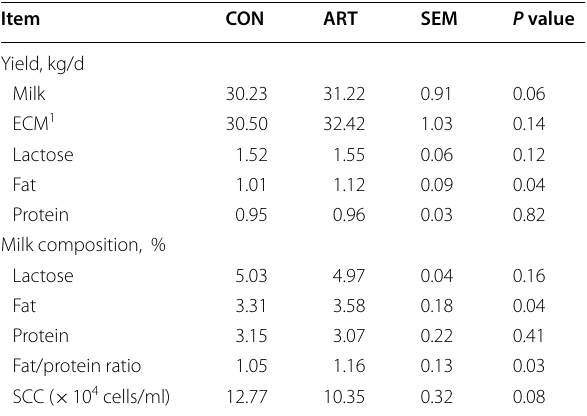
Table 2 Effect of dietary addition of ART on milk production and composition in dairy